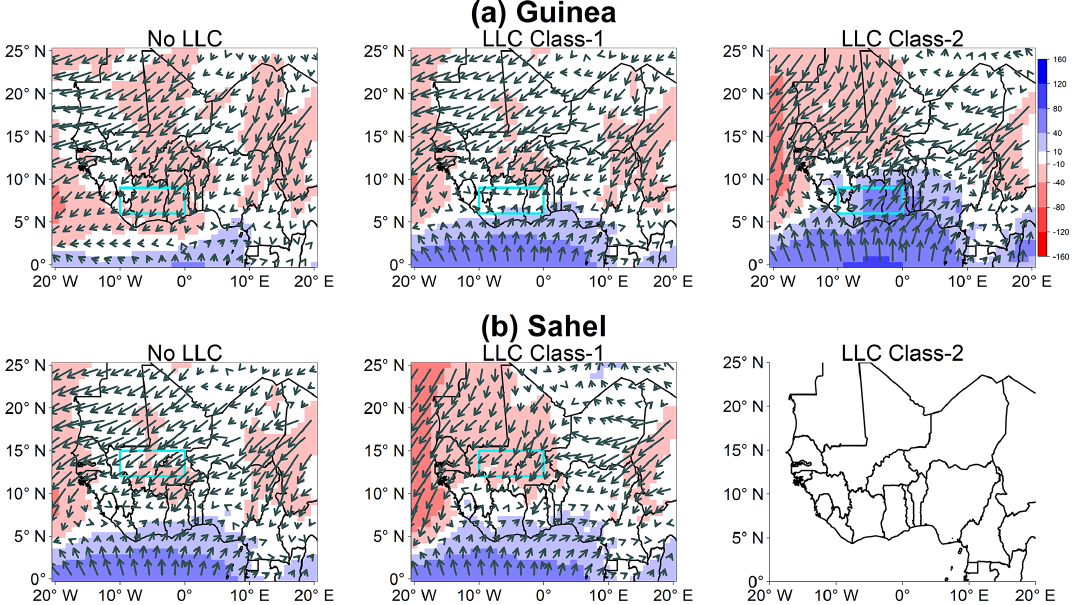
Figure 6. Same as Fig. 5 but for DJF. No event of LLC Class-2 has been extracted in the Sahel area during DJF, hence the empty plot.